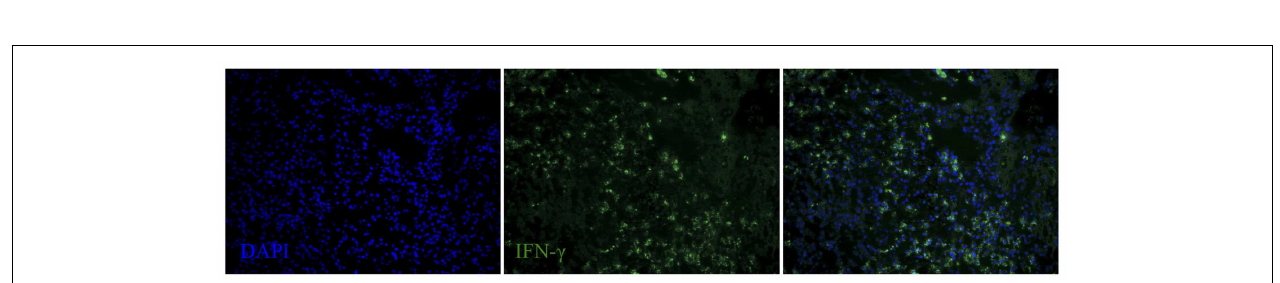
FIGURE 7 | IL-1 β , IL-4, and IL-10 expression in the spleen of a dolphin with hyperinsulinemia . Dolphin splenic tissue sections were incubated with primary anti-ovine IL-1 β , anti-bovine IL-4, or anti-bovine IL-10, followed by anti-dolphin CD2, and nuclear staining usingVECTASHIELD mounting medium with DAPI. Original magnification 20 × .